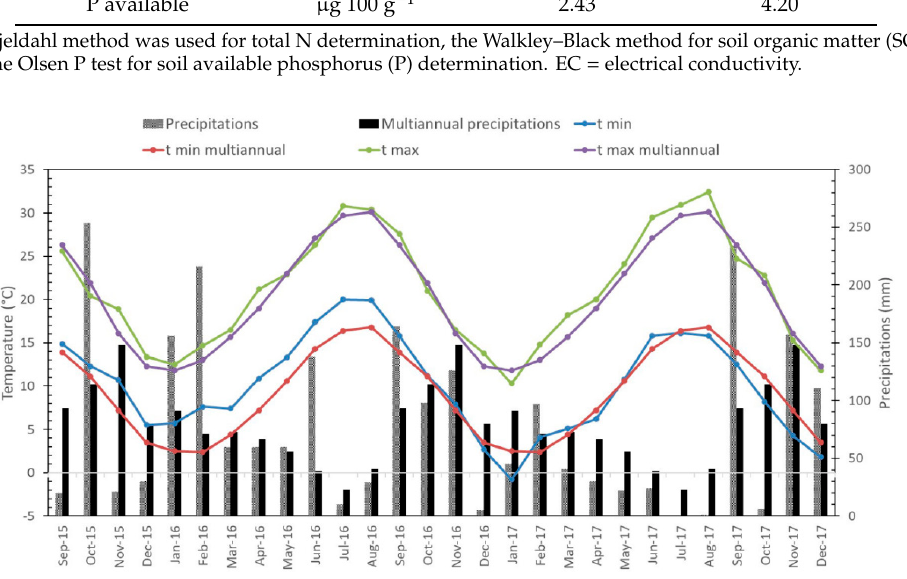
Figure 1. Total monthly precipitations (mm) and the average maximum and minimum